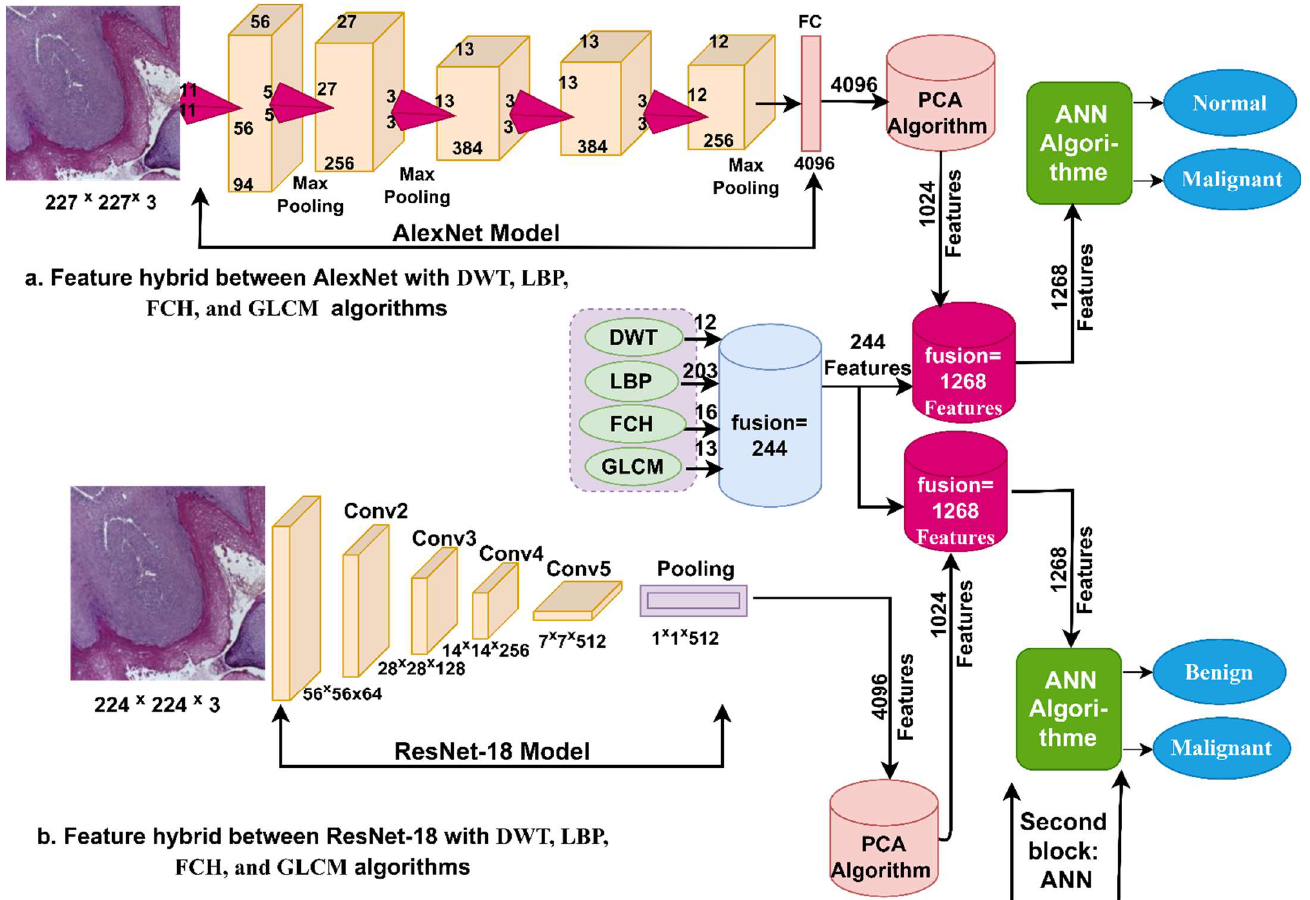
Figure 4. Methodology for histopathological image diagnosis of oral cancer using the hybrid features technique between CNN model, DWT, LBP, FCH, and GLCM models.